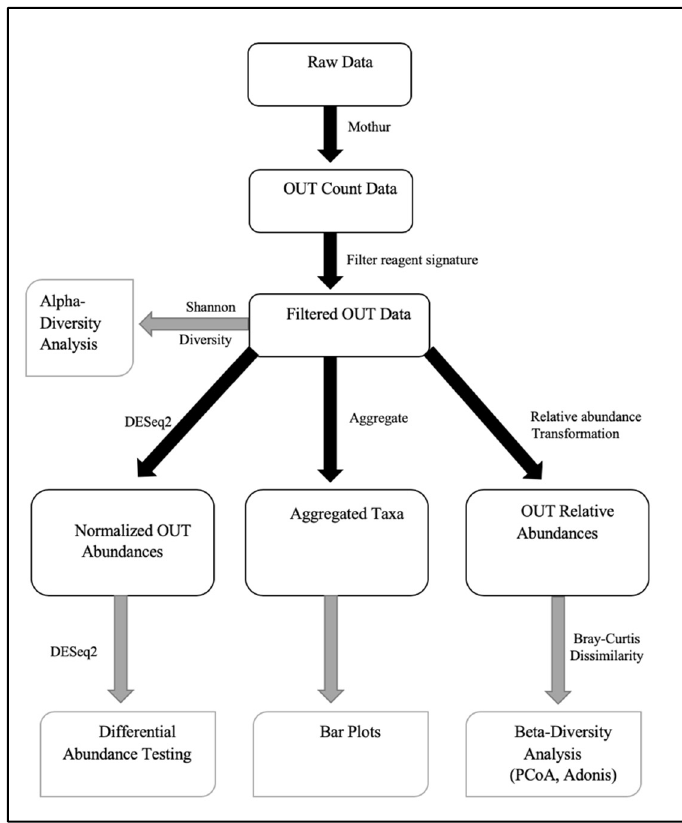
Figure 1. Analytical flow chart. 263